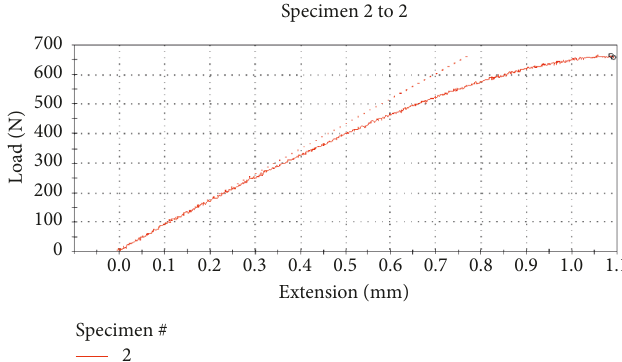
Figure 7: Tensile load-extension curve for specimen II.